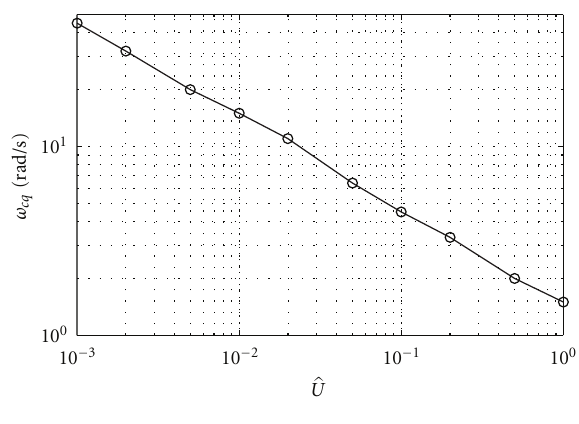
Figure 4: Relation between normalized input amplitude (cid:8) U and cut- o ff frequency ω cq with α =